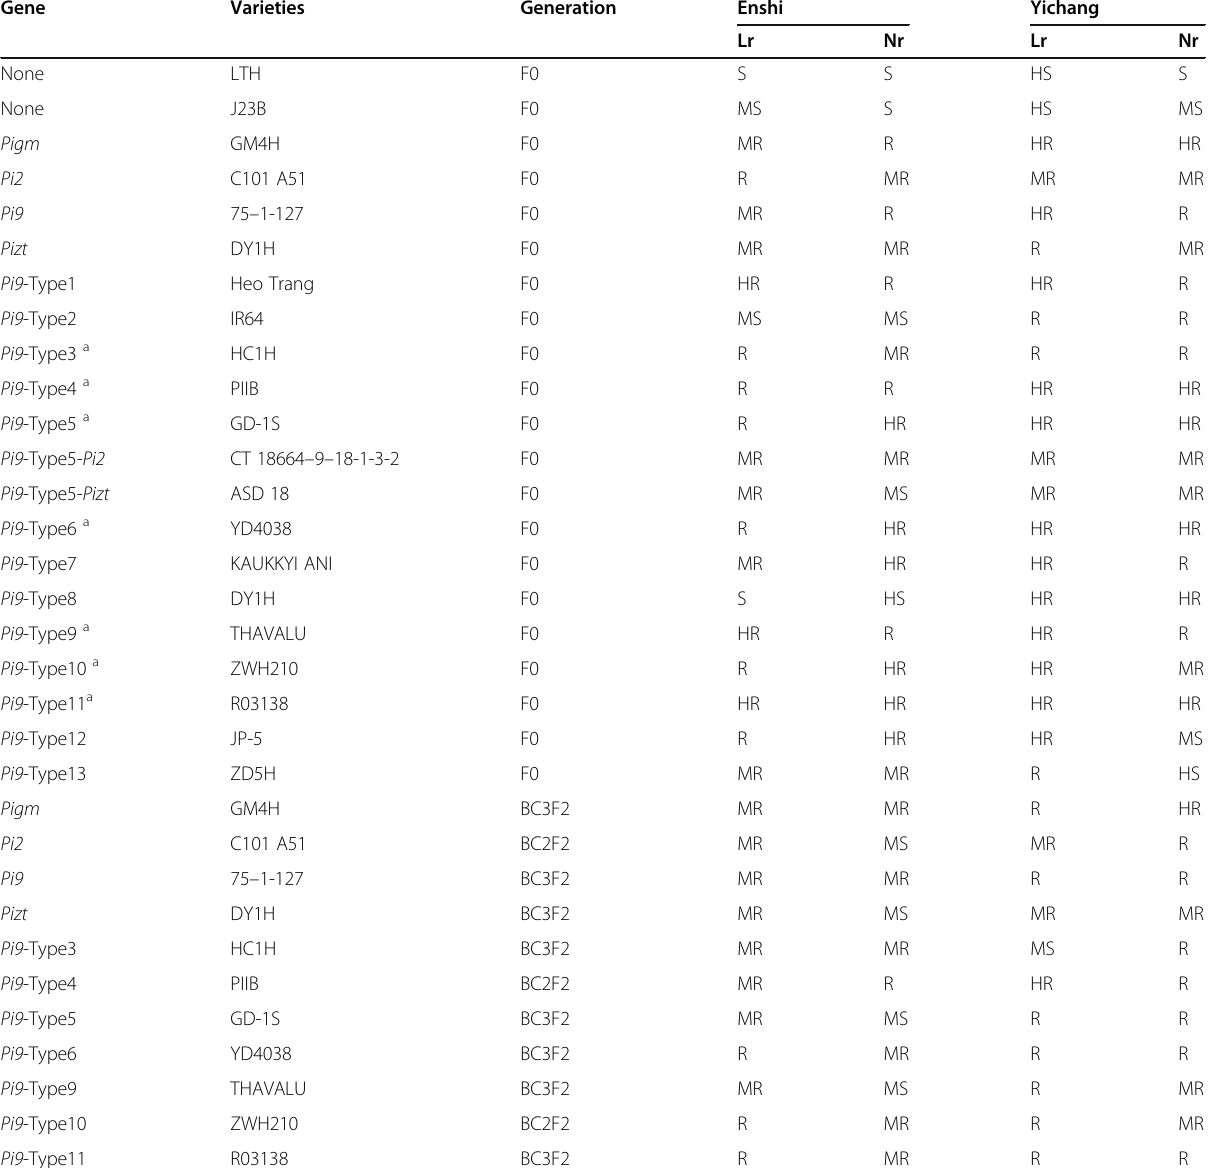
Table 5 Disease responses of Pigm , Pi2 , Pizt , Pi9 and Pi9 alleles honor plants to M. oryzae isolates